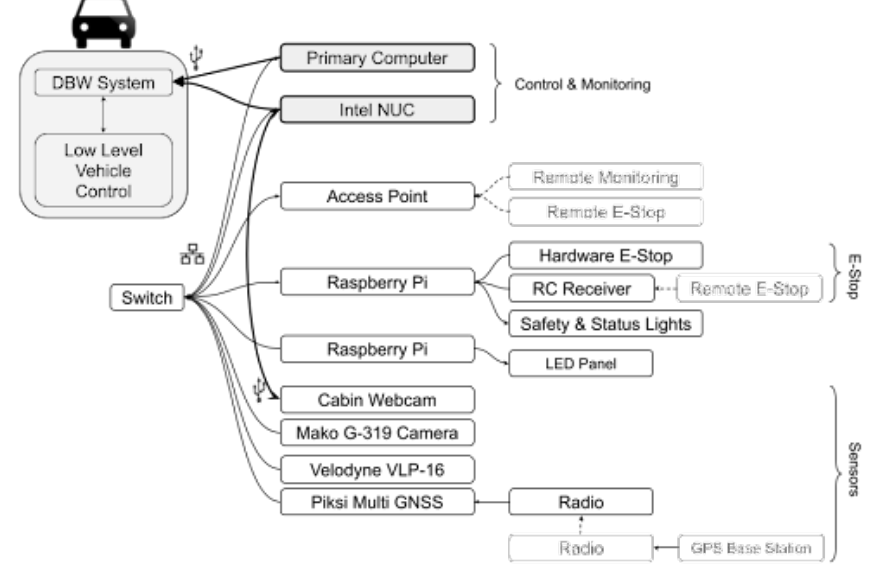
Figure 9. An image of the ACTor 1 hardware setup